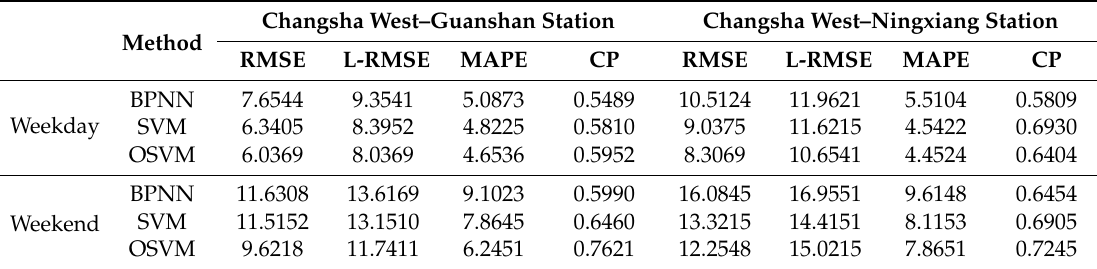
Table 5. Error evaluation of forecasting freeway travel